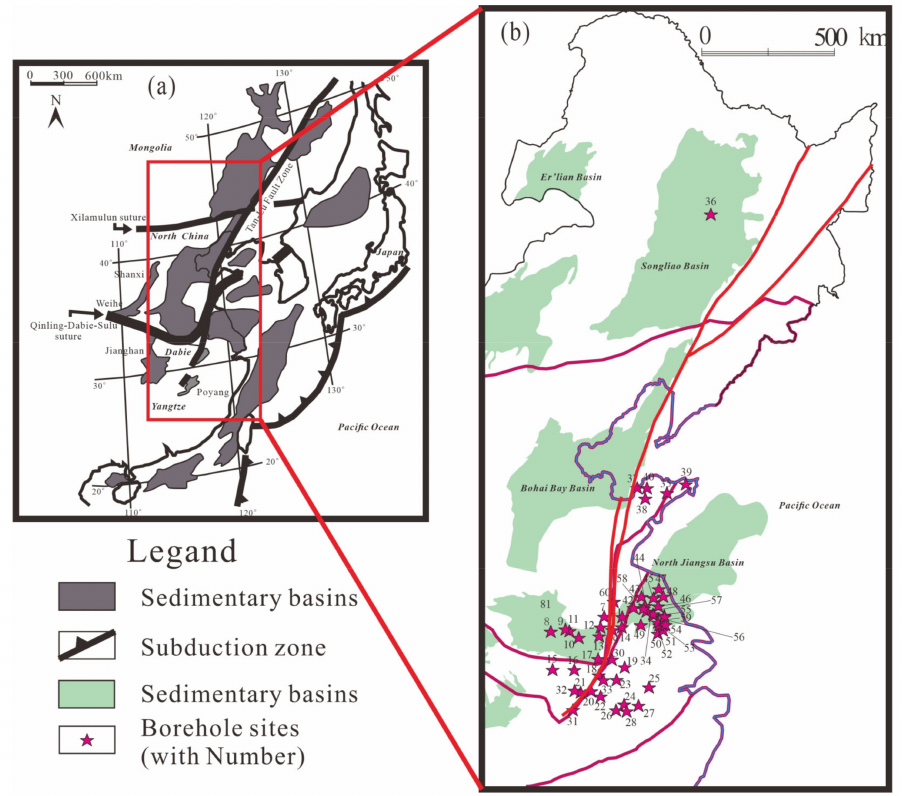
Figure 1. ( a ) Schematic geological map in East Asia (modified after [8]); ( b ) distribution of borehole locations for this study; ( b ) is an enlargement of the red rectangle in ( a